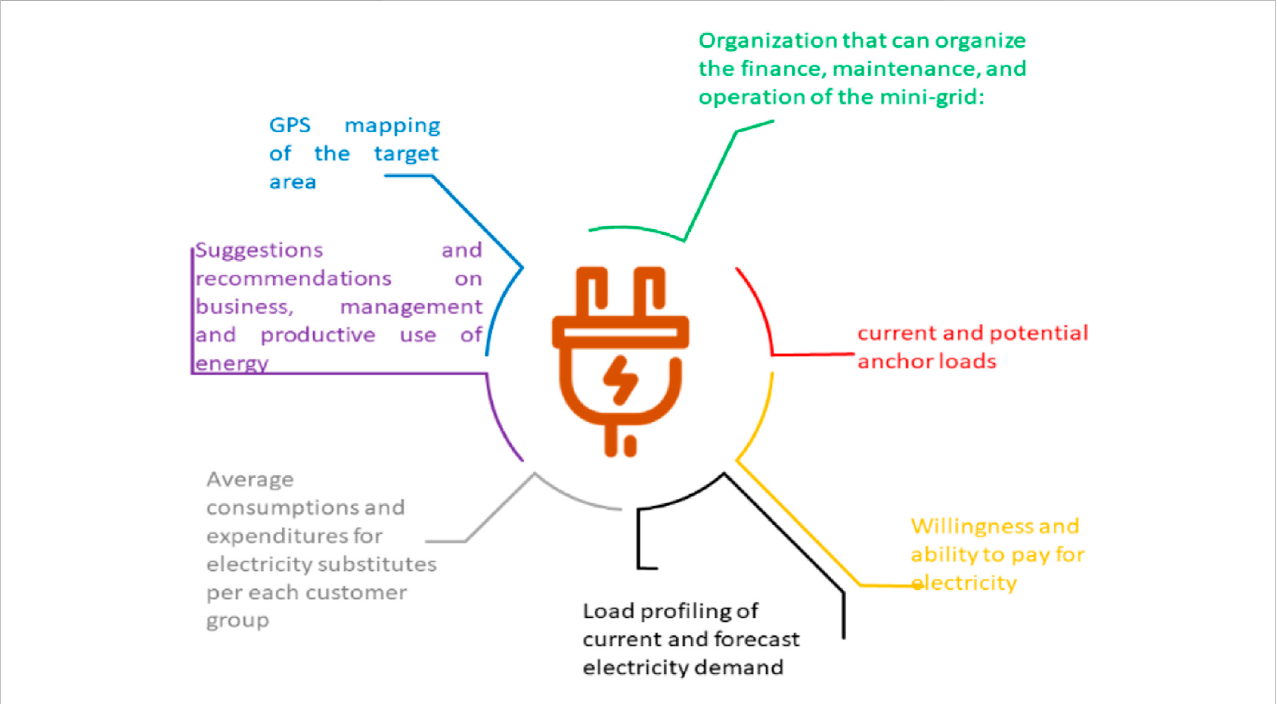
FIGURE 3 A summary of the outputs offered by energy needs assessment (Nsafon et al.,